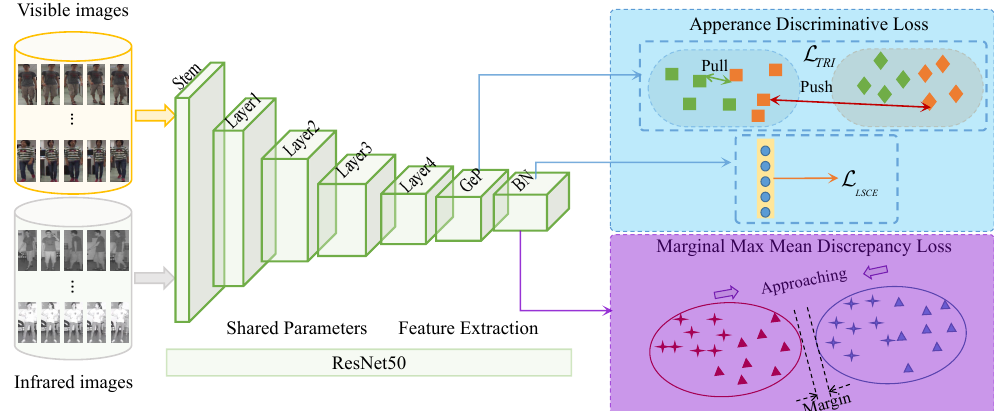
Figure 3. The visible-infrared person re-identification model via margin-based modal adaptive